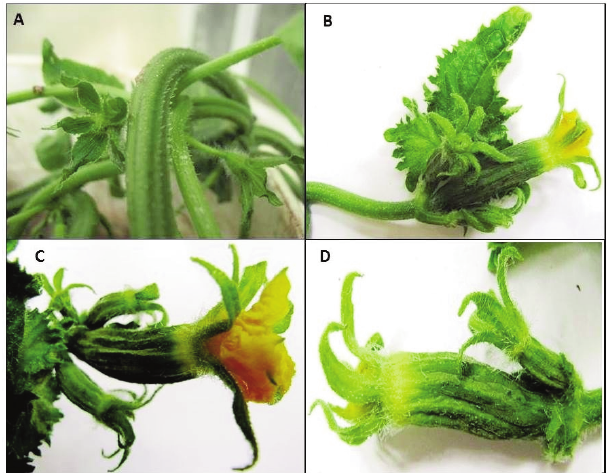
Fig. 1 ­ Flower virescence, phyllody and sterility in a greenhouse cucumber plant from Yazd (A) and Chaharmahal and Bakhtiari (B, C, D) provinces.